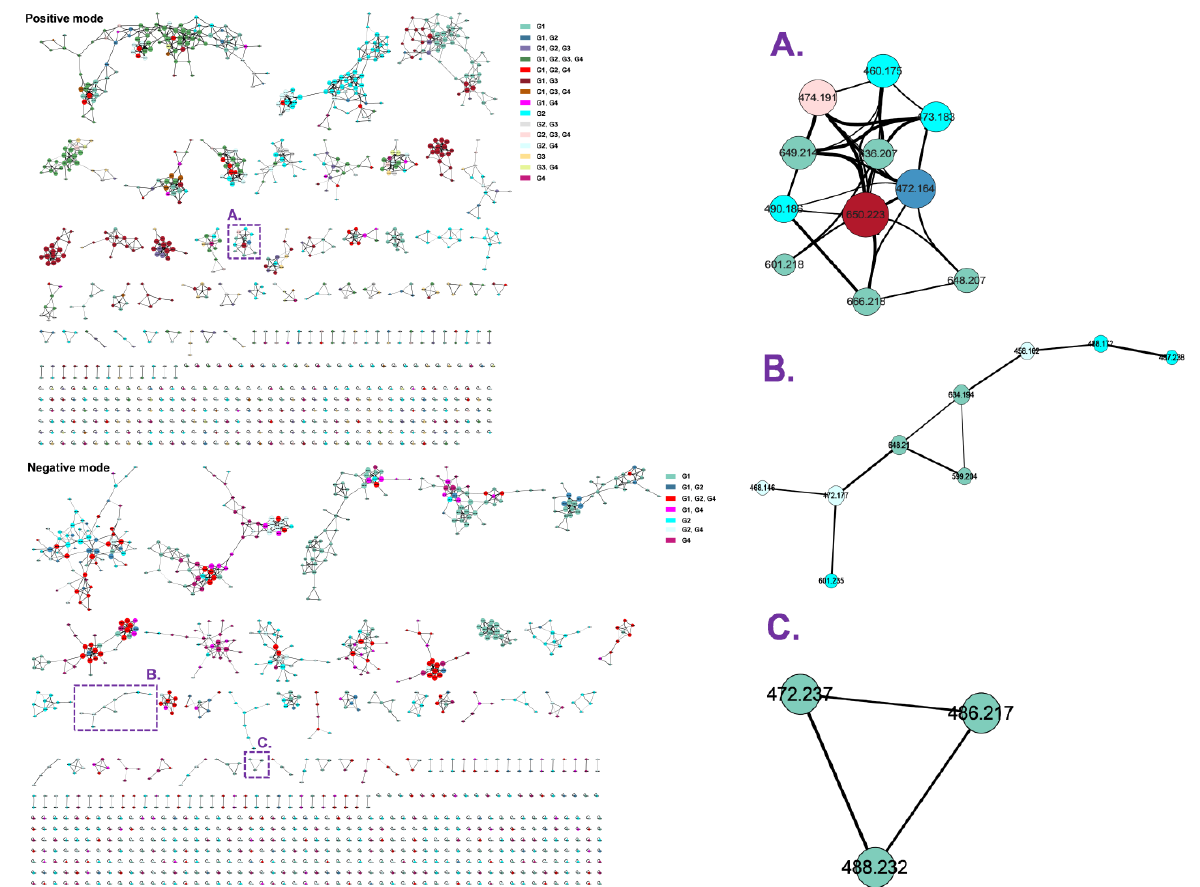
Figure 4. PND and metabolites related clusters were detected in the bile, feces, plasma and urine samples. The consensus MS/MS spectrums with identical precursor mass are represented by nodes (circles). The color of the node is referring to the presence characteristics of metabolites in various samples. The edges (lines) are connecting the nodes in accordance with the “cosine score” (fragment match/similarity score ranging 0.7 – 1), and the thickness of the edges is related to the relative abundance of metabolites within a network. Bile, feces, plasma and urine samples are labeled as G1, G2, G3 and G4, respectively. Three clusters ( A – C ) were selected and discussed in this article.